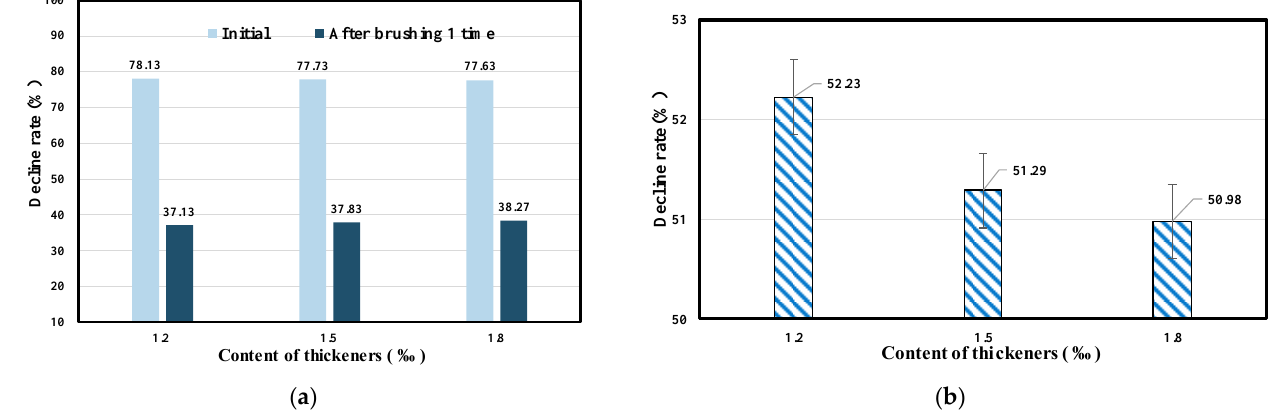
Figure 8. Design 3: ( a ) the change in the reflection rate and ( b ) the decline rate (content of thickeners).